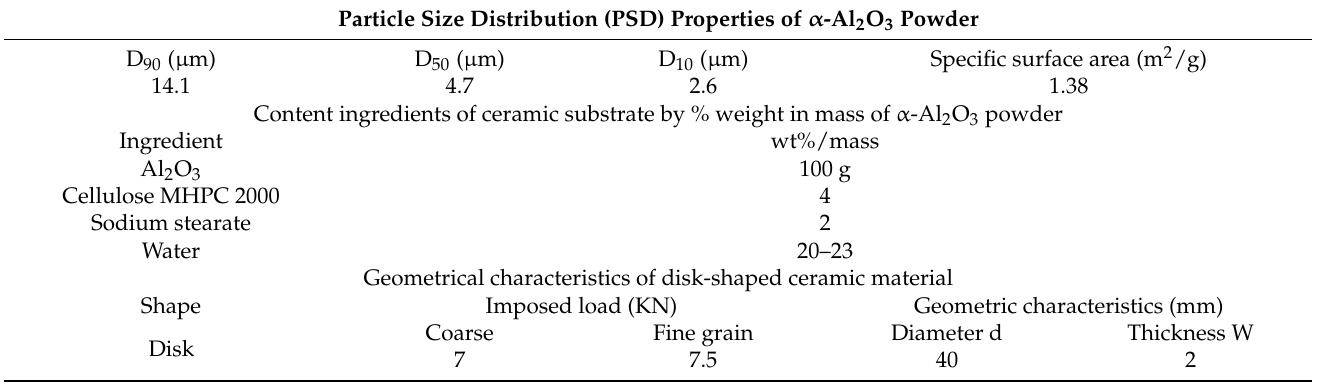
Table 2. Technical features of α -Al 2 O 3 ceramic support material .